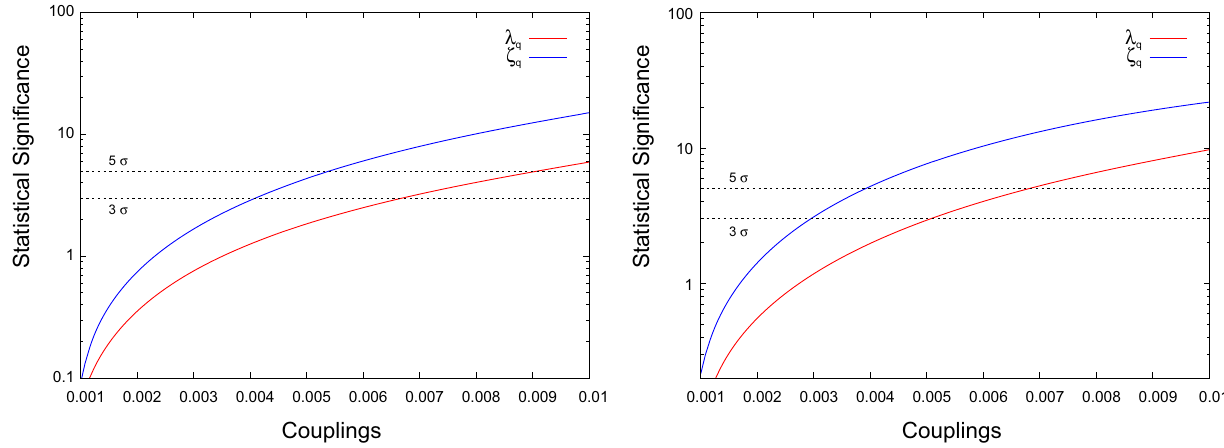
Fig. 6 The statistical significance as a function of the anomalous FCNC top couplings strengths after applying all cuts for leptonic (on the left) and hadronic (on the right) channels at L int = 100 fb − 1 . Only one coupling ( λ q or ζ q ) at a time is varied from its SM value)